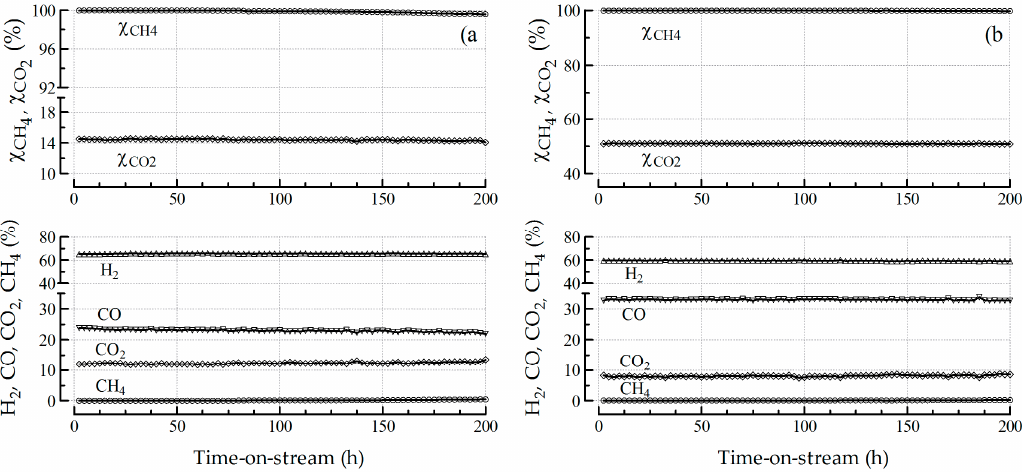
Figure 12. Biogas SR ( a ) and OSR ( b ) stability over F40 catalyst. CH 4 conversion, CO 2 conversion and 12. effluent composition as a function of time-on-stream (T SET = 900 ◦ C; WHSV = 70,000 NmL · g − 1 · h − 1